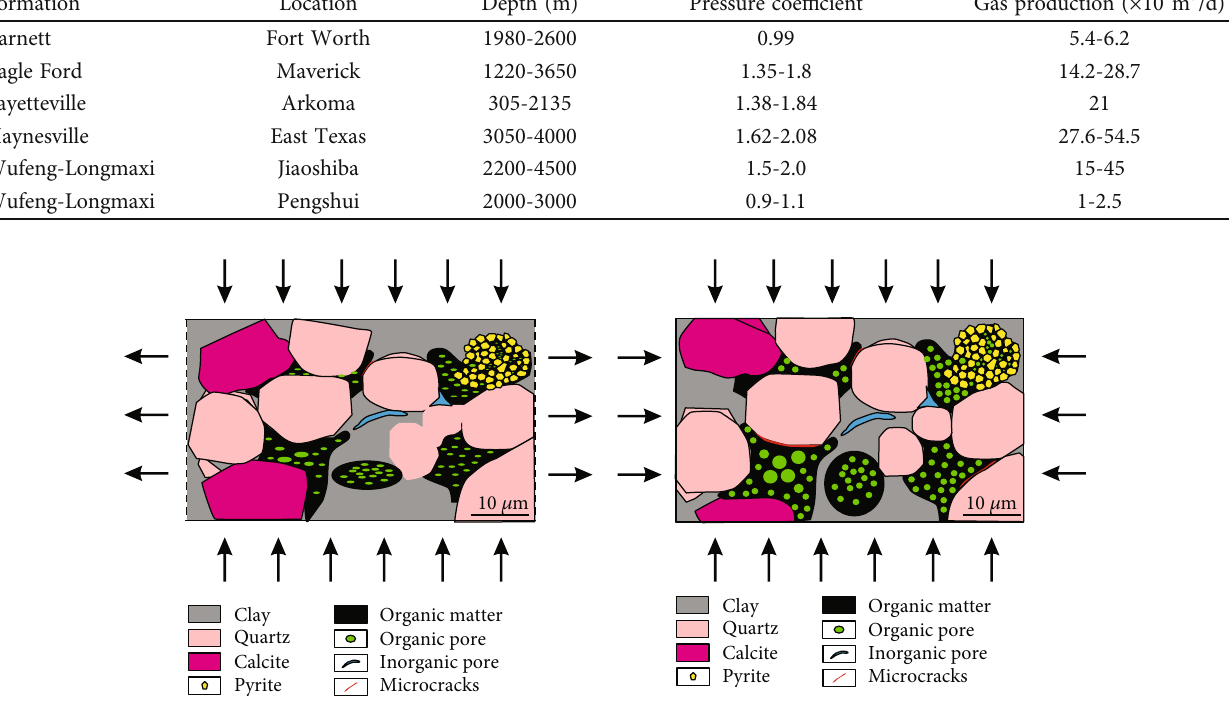
Figure 11: Development mechanism of organic matter pores in di ff erent formation pressure